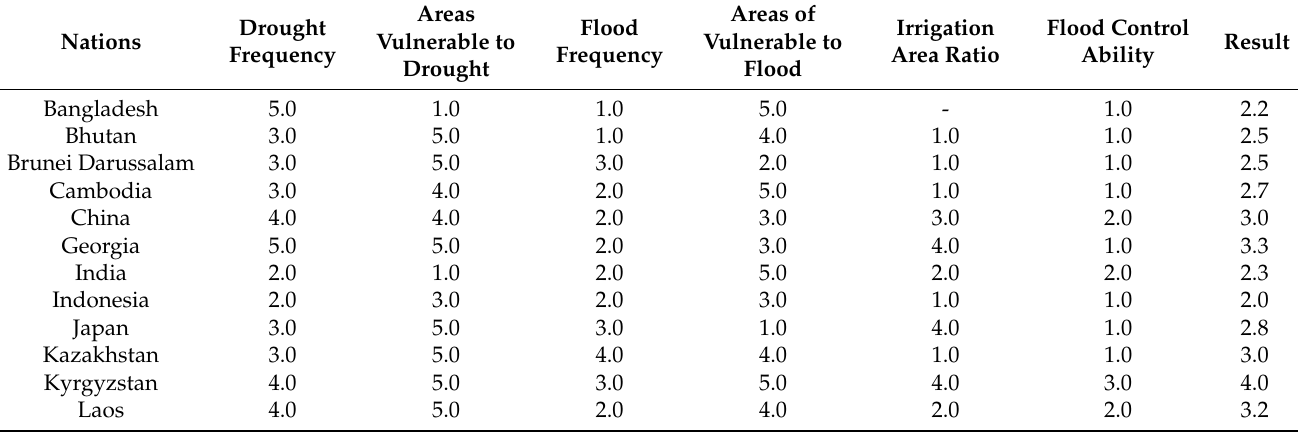
Table 9. Assessment result of resilience to water-related